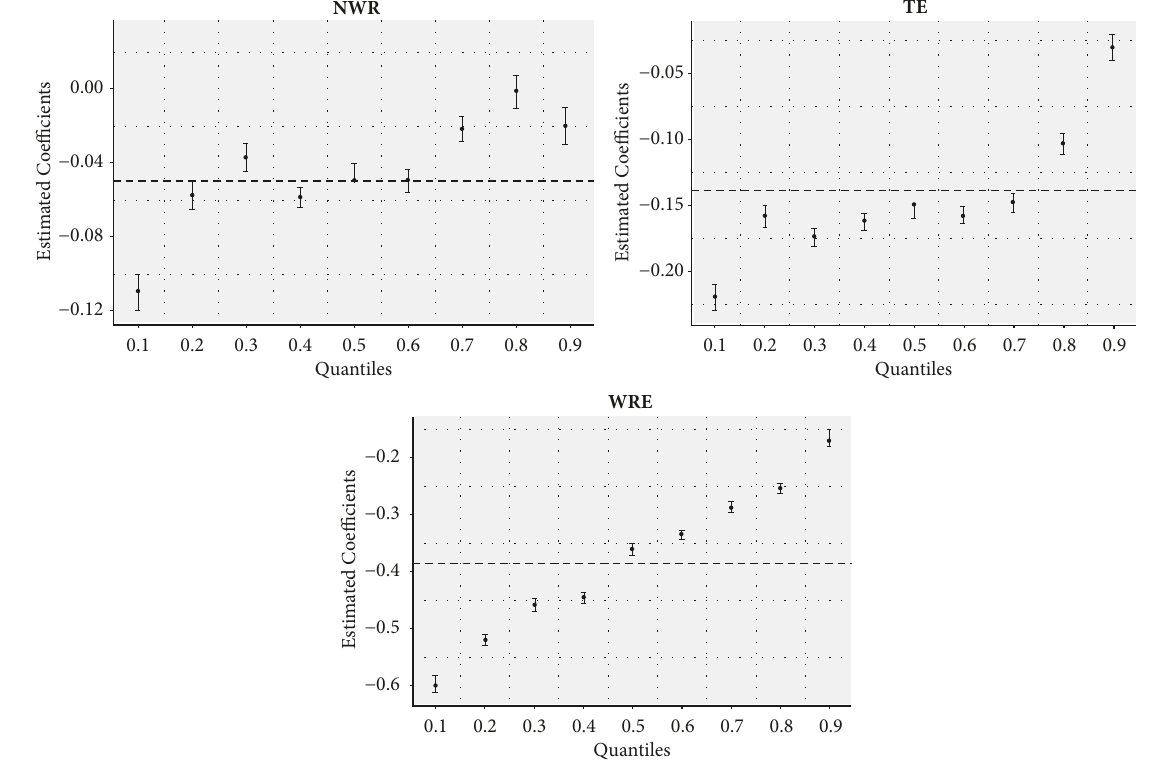
Figure 2: Regression estimates and 95% credible intervals for Bayesian quantile